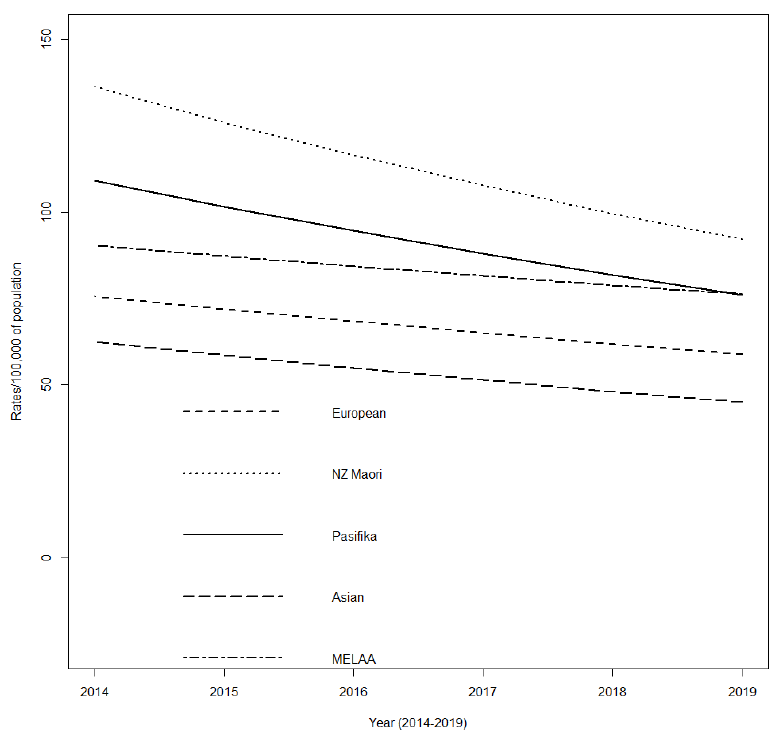
Figure 2. Incidence rates of total antibiotic dispensing for children and young adults with cerebral palsy by ethnicity, Aotearoa New Zealand; 2014–2019. palsy by ethnicity, Aotearoa New Zealand;